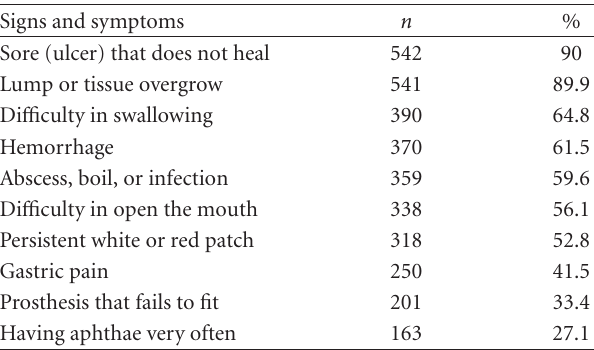
Table 4: Mostly mentioned early manifestations of oral